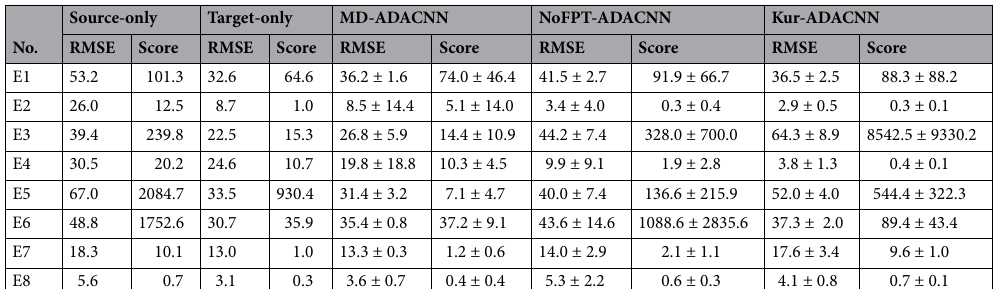
Table 5. RMSE/score ± standard deviation comparison between source-only, target-only, NoFPT-ADACNN, Kur-ADACNN and MD-ADACNN on FEMTO dataset and XJTU-SY dataset.